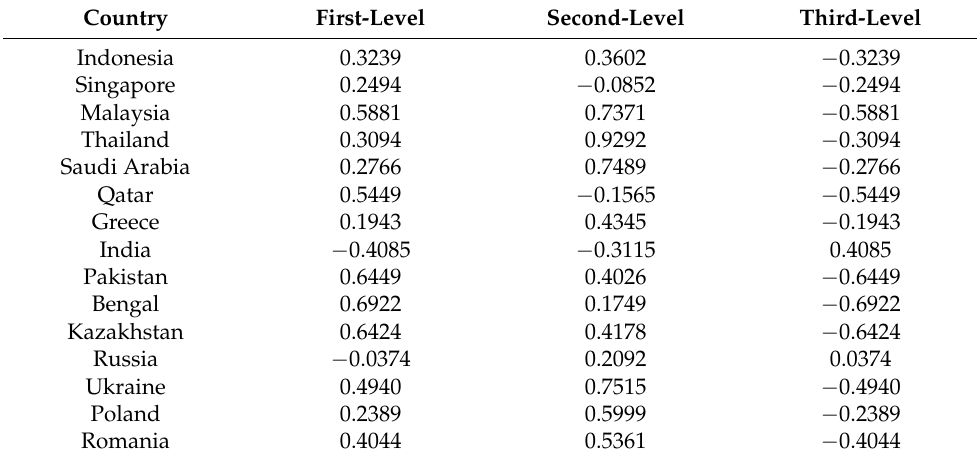
Table 6. Comprehensive connection degree.